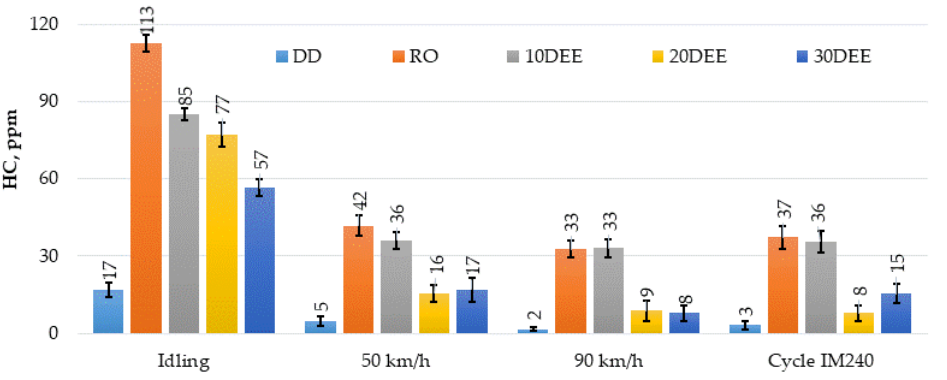
Figure 7. HC emissions of DD, RO, 10DEE, 20DEE and 30DEE in different testing conditions.